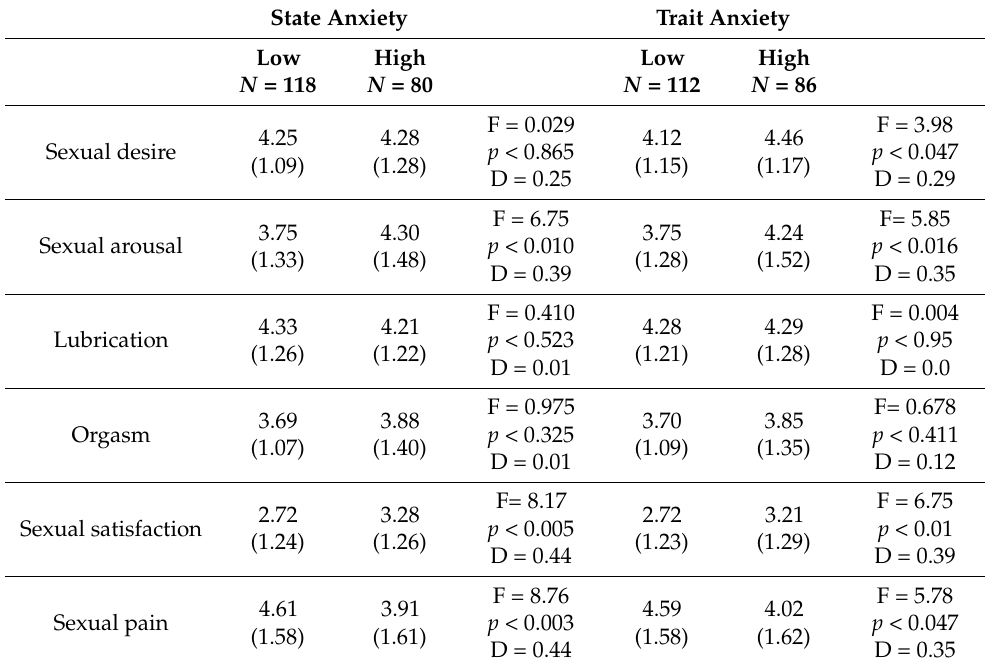
Table 4. Mean scores and standard deviation of FSFI domains according to anxiety levels (low versus moderate to severe). NS, not significant.